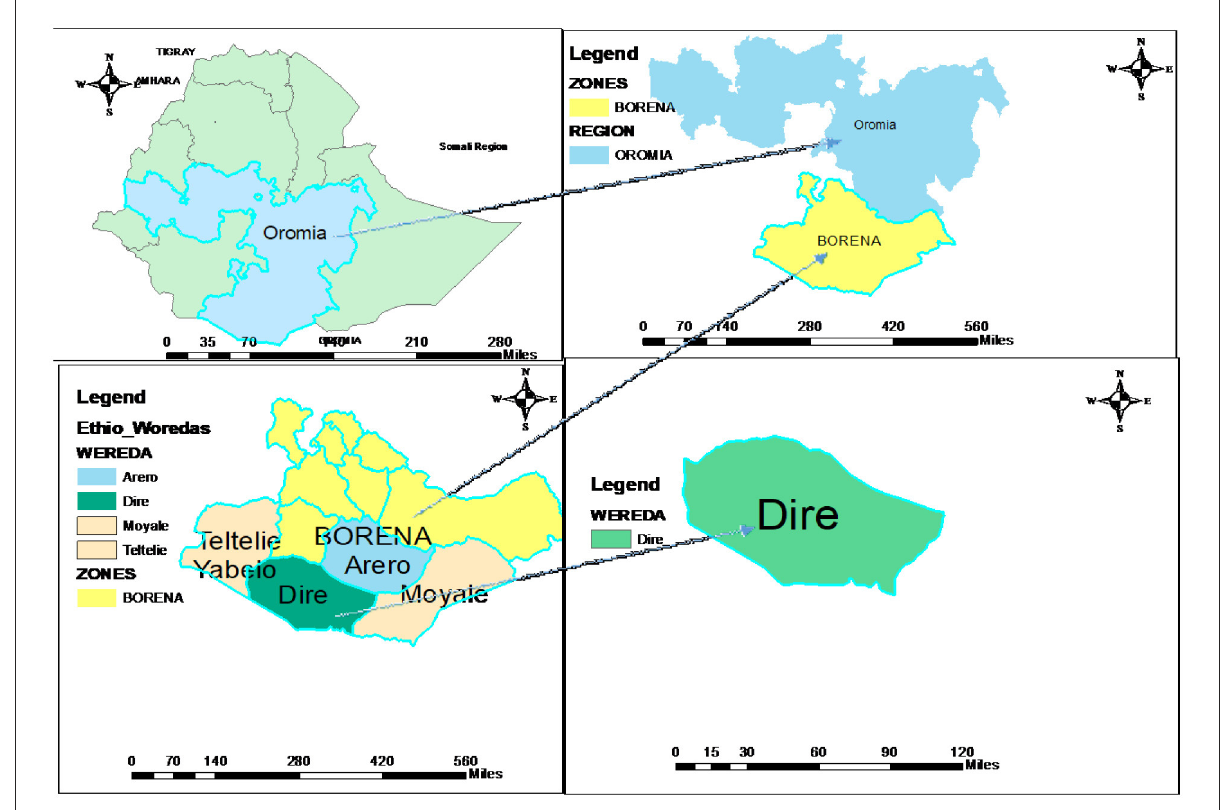
FIGURE1 Map of Dire District, Borena zone, Oromia Region, Ethiopia 2021.